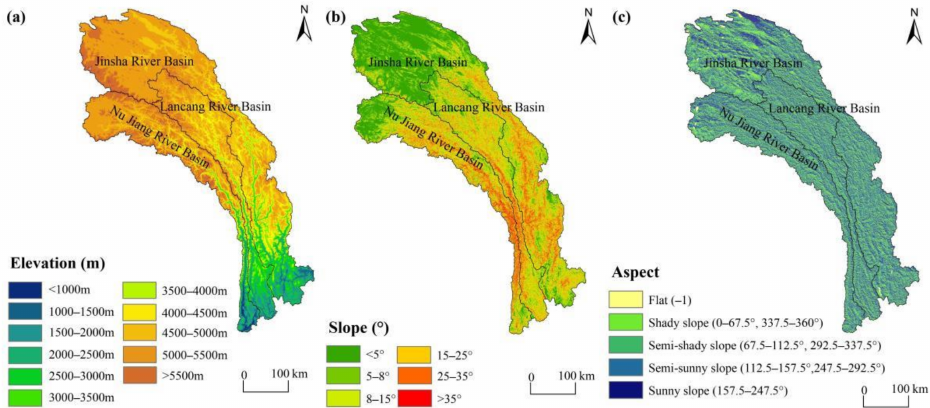
Figure 2. The hierarchical spatial distribution of topographic factors in the study area. ( a ) elevation gradients, ( b ) slope distribution, and ( c ) aspect classification across the